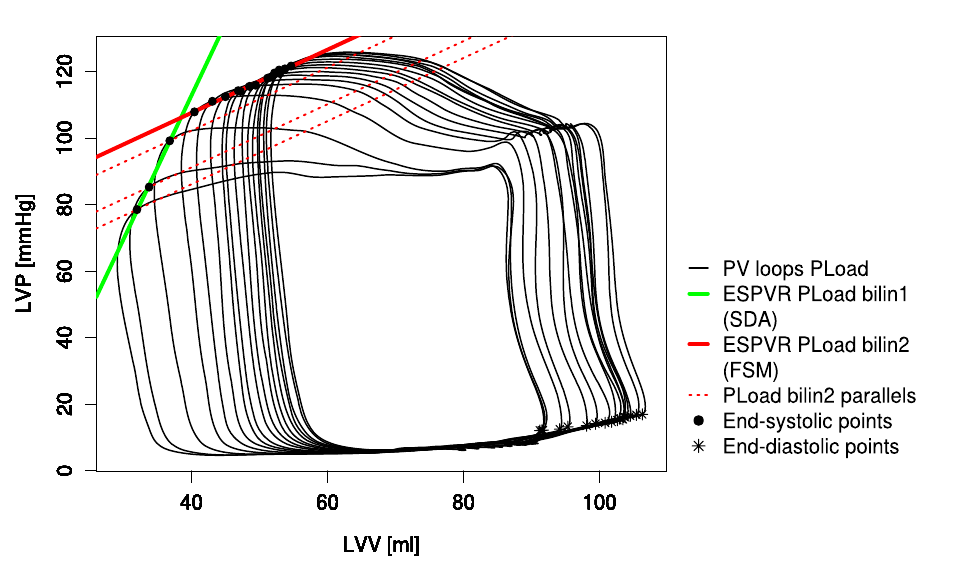
Figure 6. Pressure volume loops of an afterload intervention with the associated end-systolic pressure volume relationships (ESPVR) obtained from the first (PLoad bilin1) and second phases (PLoad bilin2). The end- systolic values (black dots) of PLoad bilin1 are components of different ESPVRs (dotted red lines) with a slope equal to that of the ESPVR bilin2 values. Phase 1 reflects the mechanism of “shortening deactivation”, and phase 2 represents the Frank-Starling mechanism or “fast force